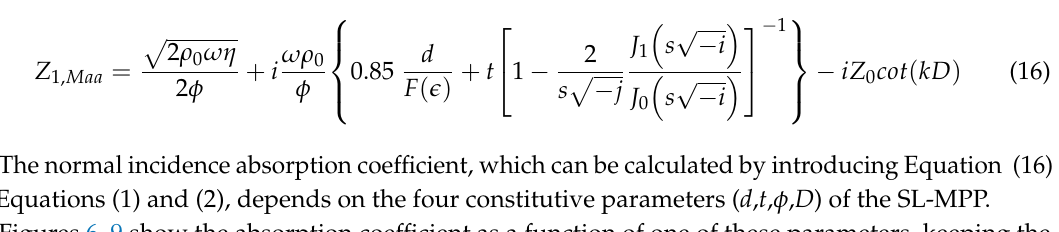
Figure 5. Graphical representation of the Fok function.